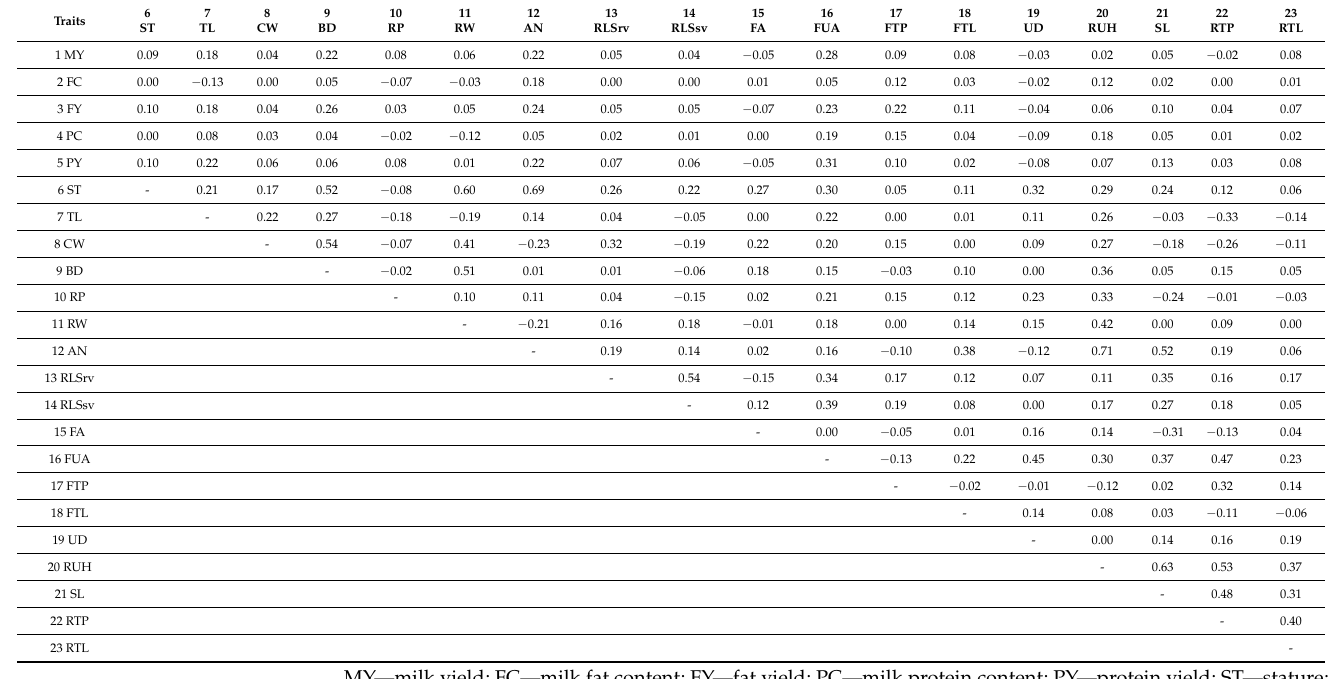
Table 6. Genetic correlations (r xy ) between the milk traits and type traits.